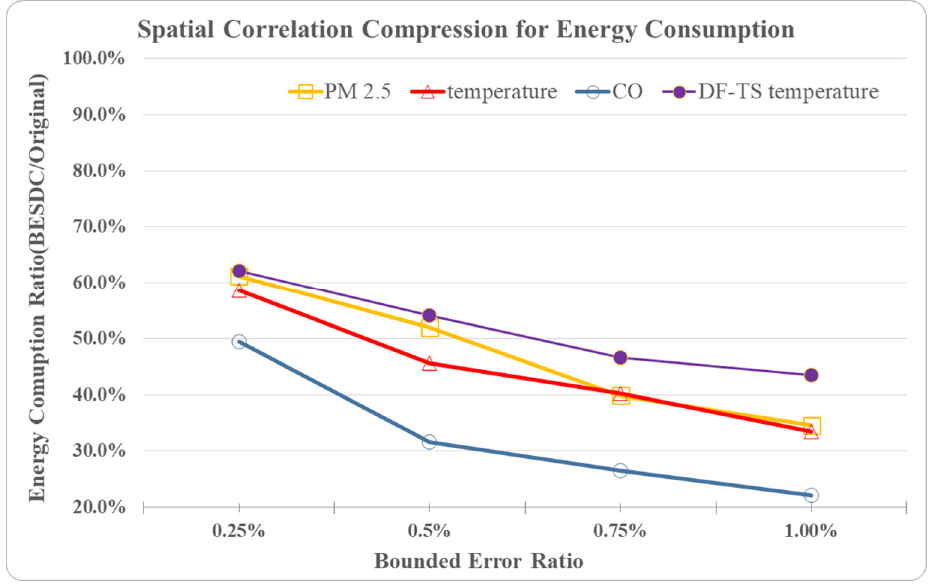
Figure 11. Energy consumption ratio in SN with “faraway” EDs by spatial correlation compression.